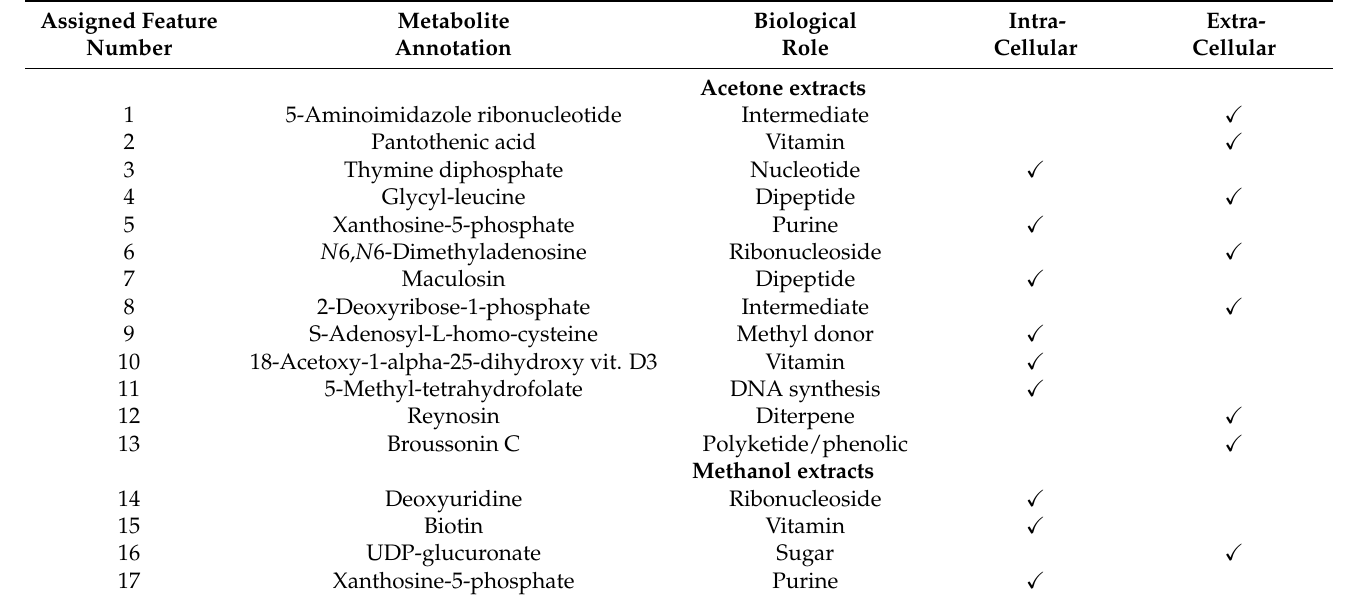
Table 1. List of annotated metabolites present in acetonic and methanolic extracts of H. roseonigra grown in batch culture and annotated from UHPLC–MS data *.